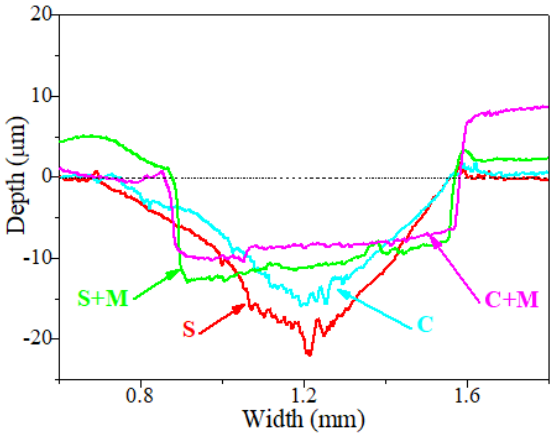
Figure 11. Measurement results for different wear scar profiles: S, Slipper substrate, C, Ni80Al20 coating, S + M, Substrate with MoS 2 film and C + M, Ni80Al20-MoS 2 composite coating.